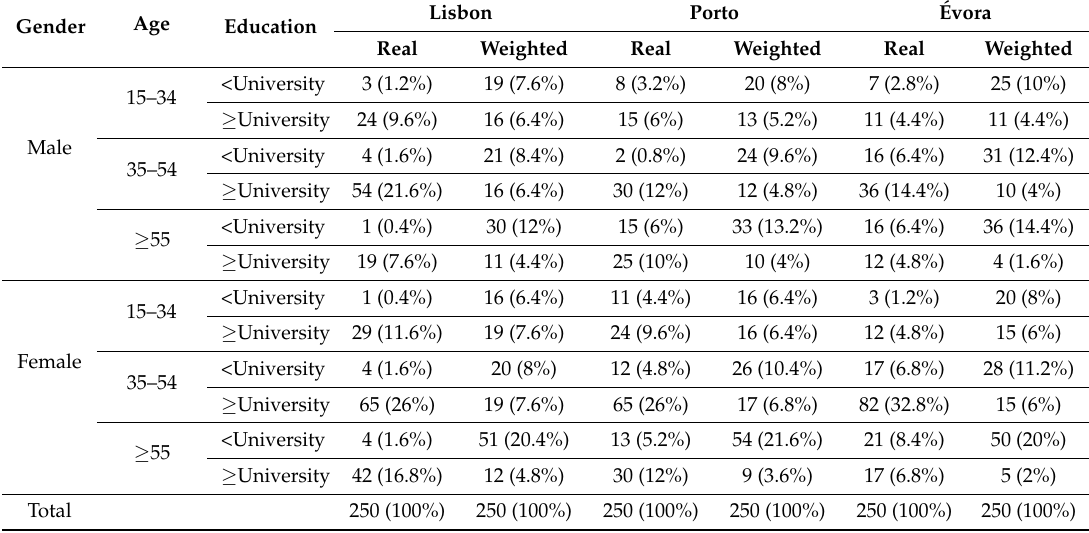
Table 2. Socioeconomic characteristics of respondents and the weighted sample according to census